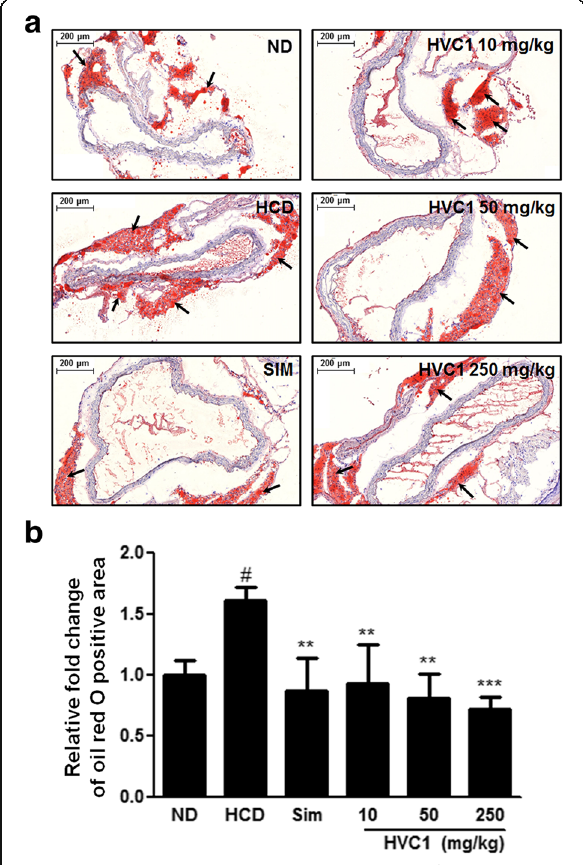
Fig. 1 Effect of HVC1 on plaque formation in LDLR − / − mice fed a HCD. ( a ) Representative images of the aortic root and ( b ) quantitative analysis of Oil red O positive area. Oil red O staining was performed to show lipid in aortic root ( black arrows , original magnification × 100). The fold change of Oil red O positive area was quantified using Adobe Photoshop 9.0. ND: Normal diet group; HCD: High-cholesterol diet group; Sim: Simvastatin (10 mg/kg) treated with HCD group; HVC1: HVC1 treated with HCD group. The values represent mean ± S.D. (significant as compared to HCD, ** p < 0.01, *** p < 0.001, significant as compared to ND, # p <